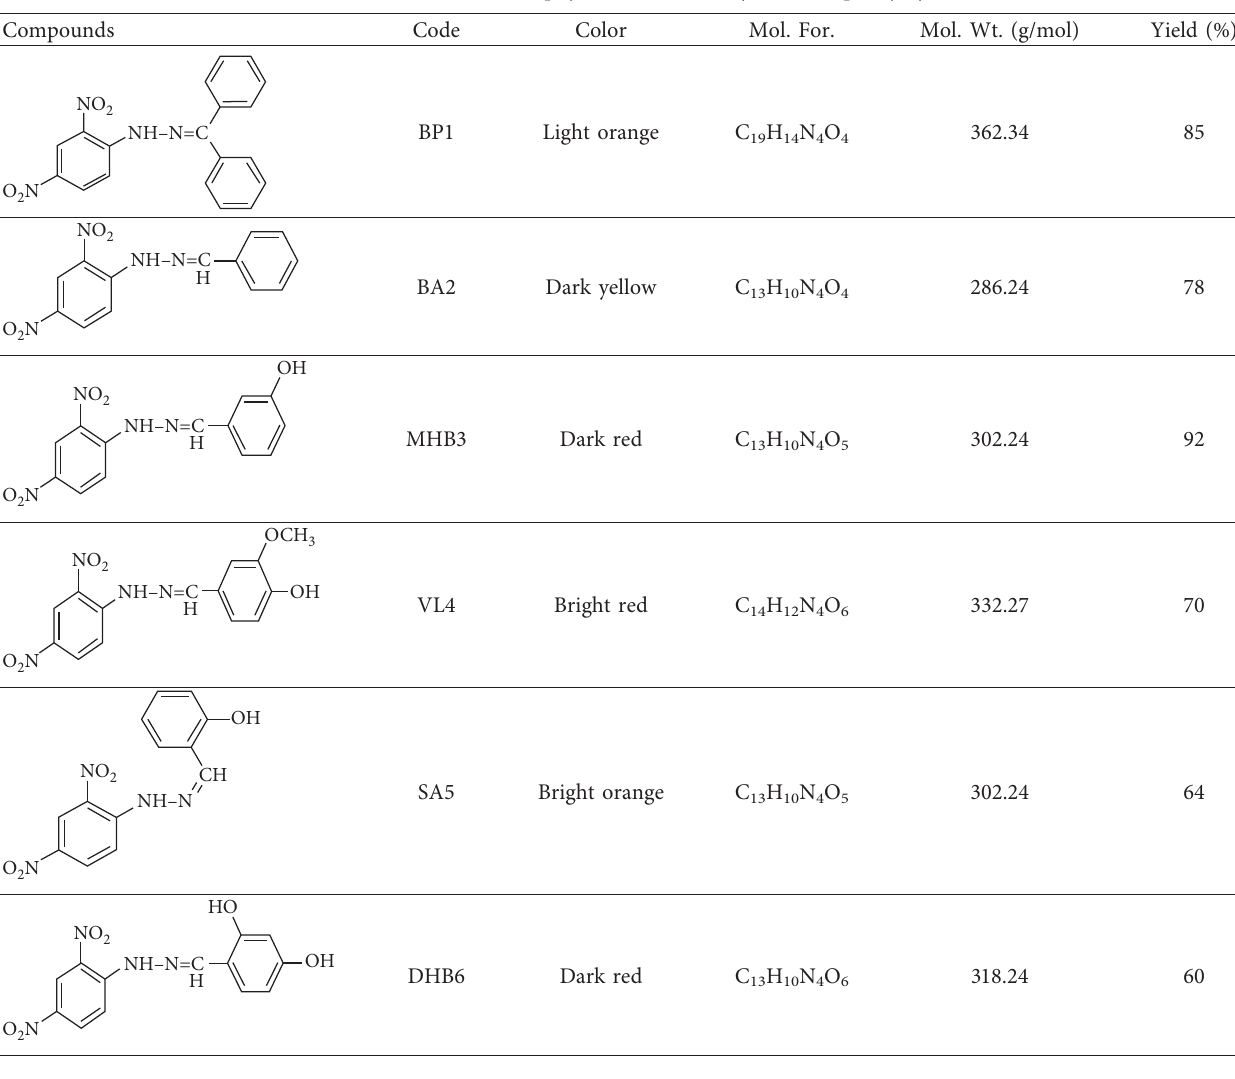
Table 1: Chemical structures and physical data of the synthesized phenylhydrazones. Compounds